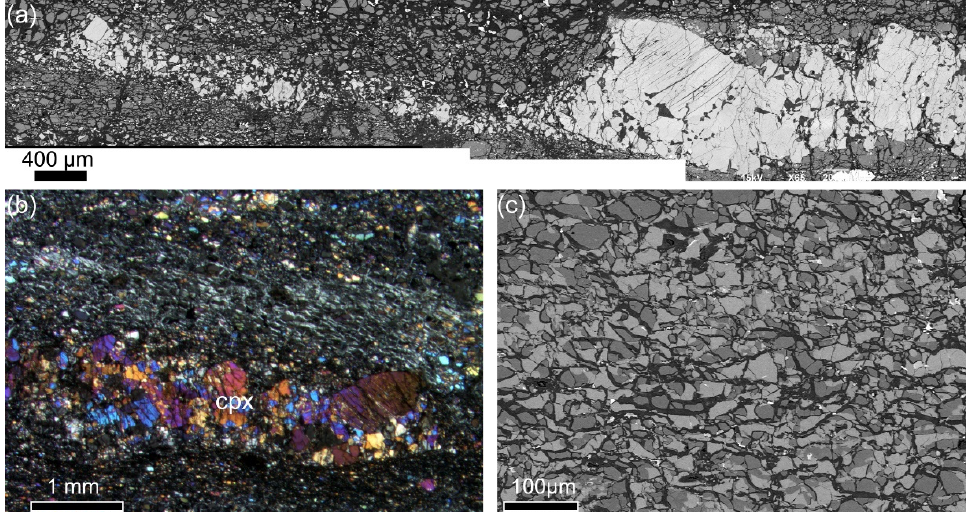
Figure 5. ( a ) BSE image of recrystallized cpx porphyroclasts adjacent to the porphyroclast cpx neoblasts, and further away a tail of cpx + olivine. ( b ) Optical microscope image with crossed polarizers of a recrystallized cpx layer. ( c ) BSE image of cpx and olivine grains in the matrix (ROI 32).